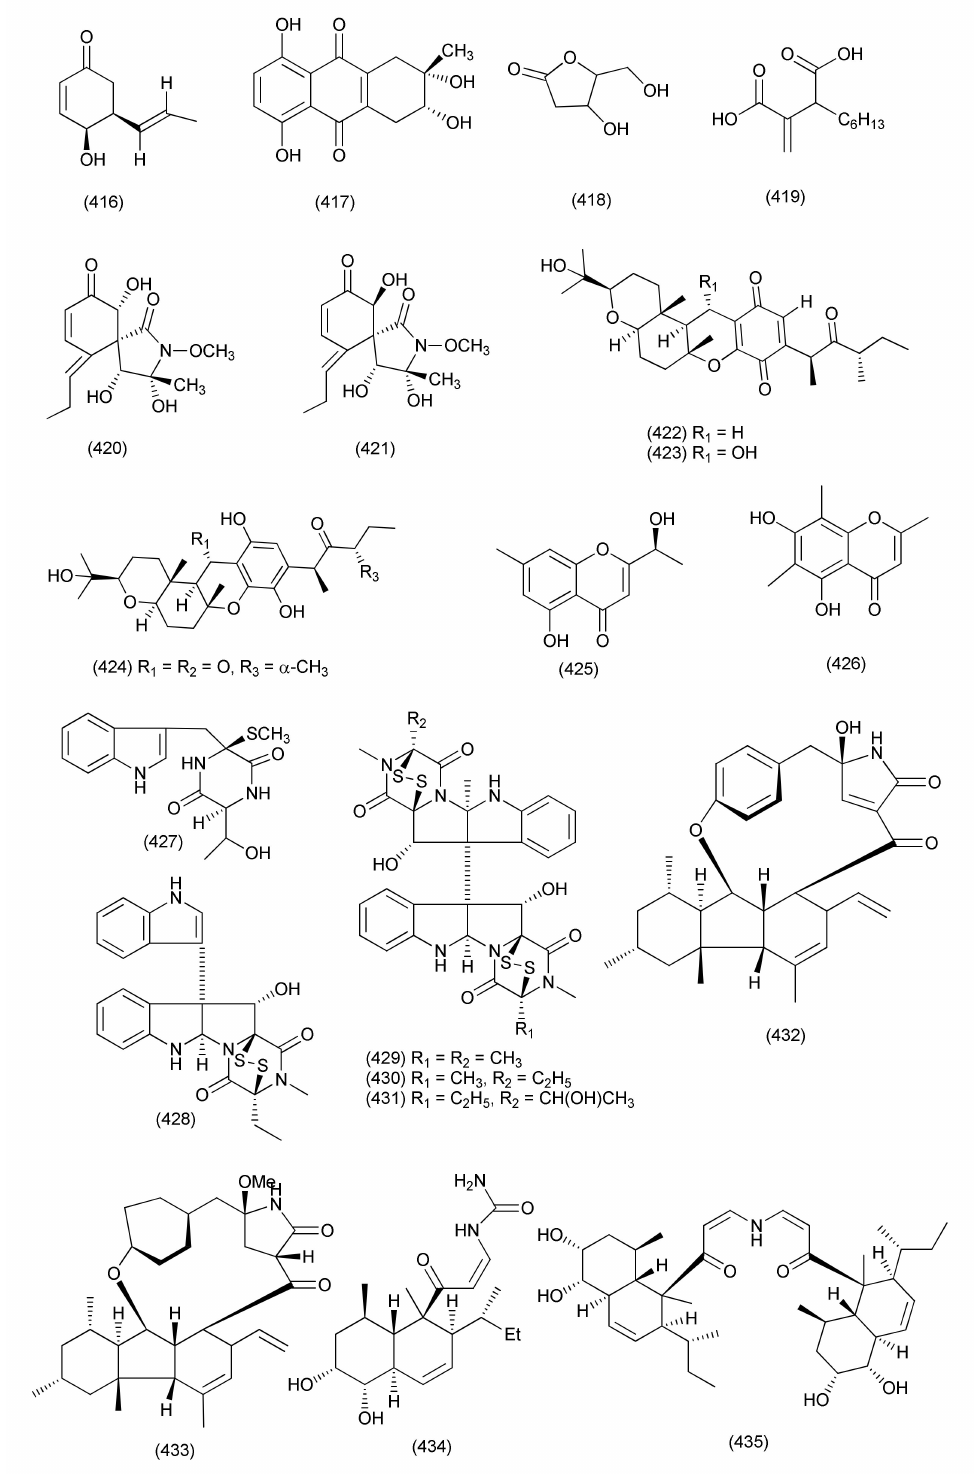
Figure 23. Structures of metabolites 416 – 435 isolated from Minor Anamorphic